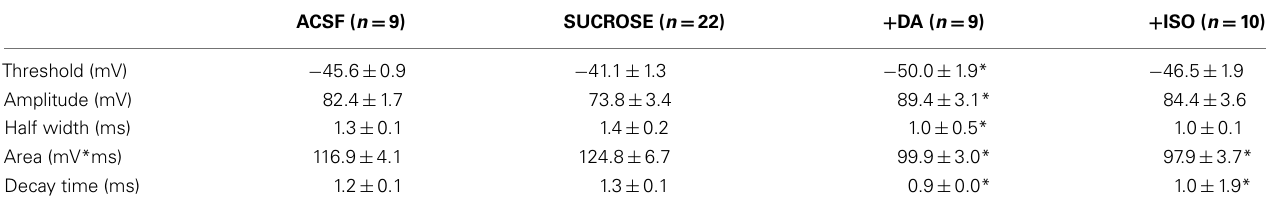
Table 2 | Comparison of action potential parameters (compare Figures 5 and 7) inACSF and sucrose prepared hippocampal slices, and after dopamine or isoproterenol treatment of sucrose prepared